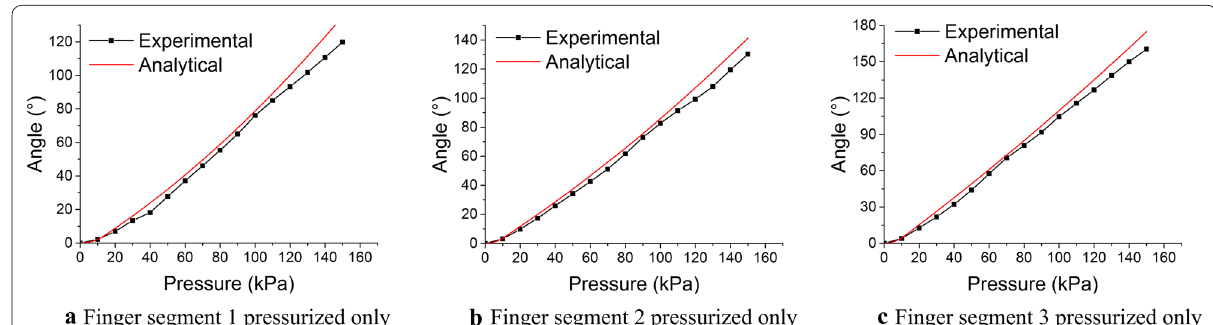
Figure 10 Bending angles of the fingertip under the pressurization of different finger